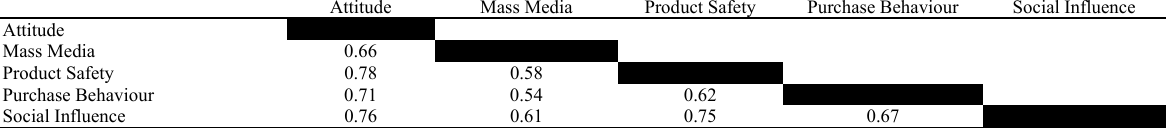
The Result of Discriminant Validity using Heterotrait-Monotrait (HTMT) Attitude